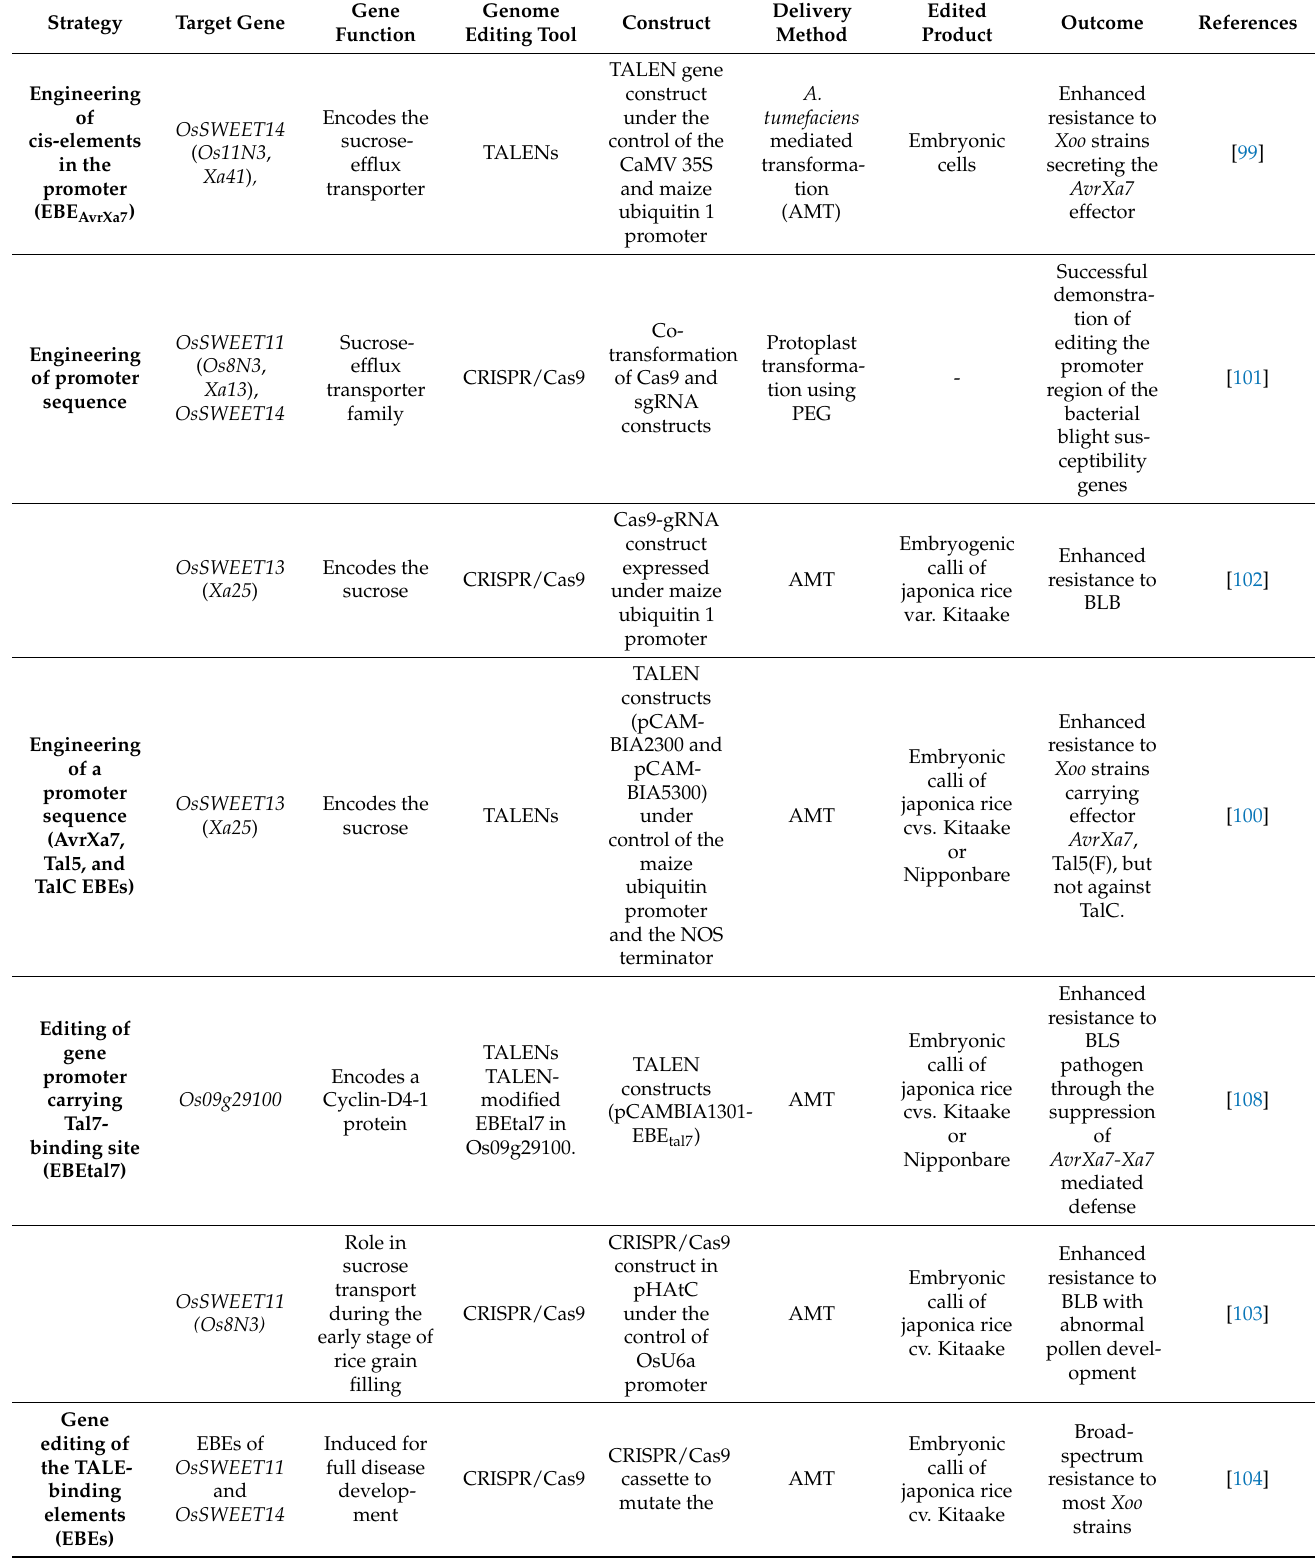
Table 3. Targeted genome editing for disease resistance in rice against bacterial